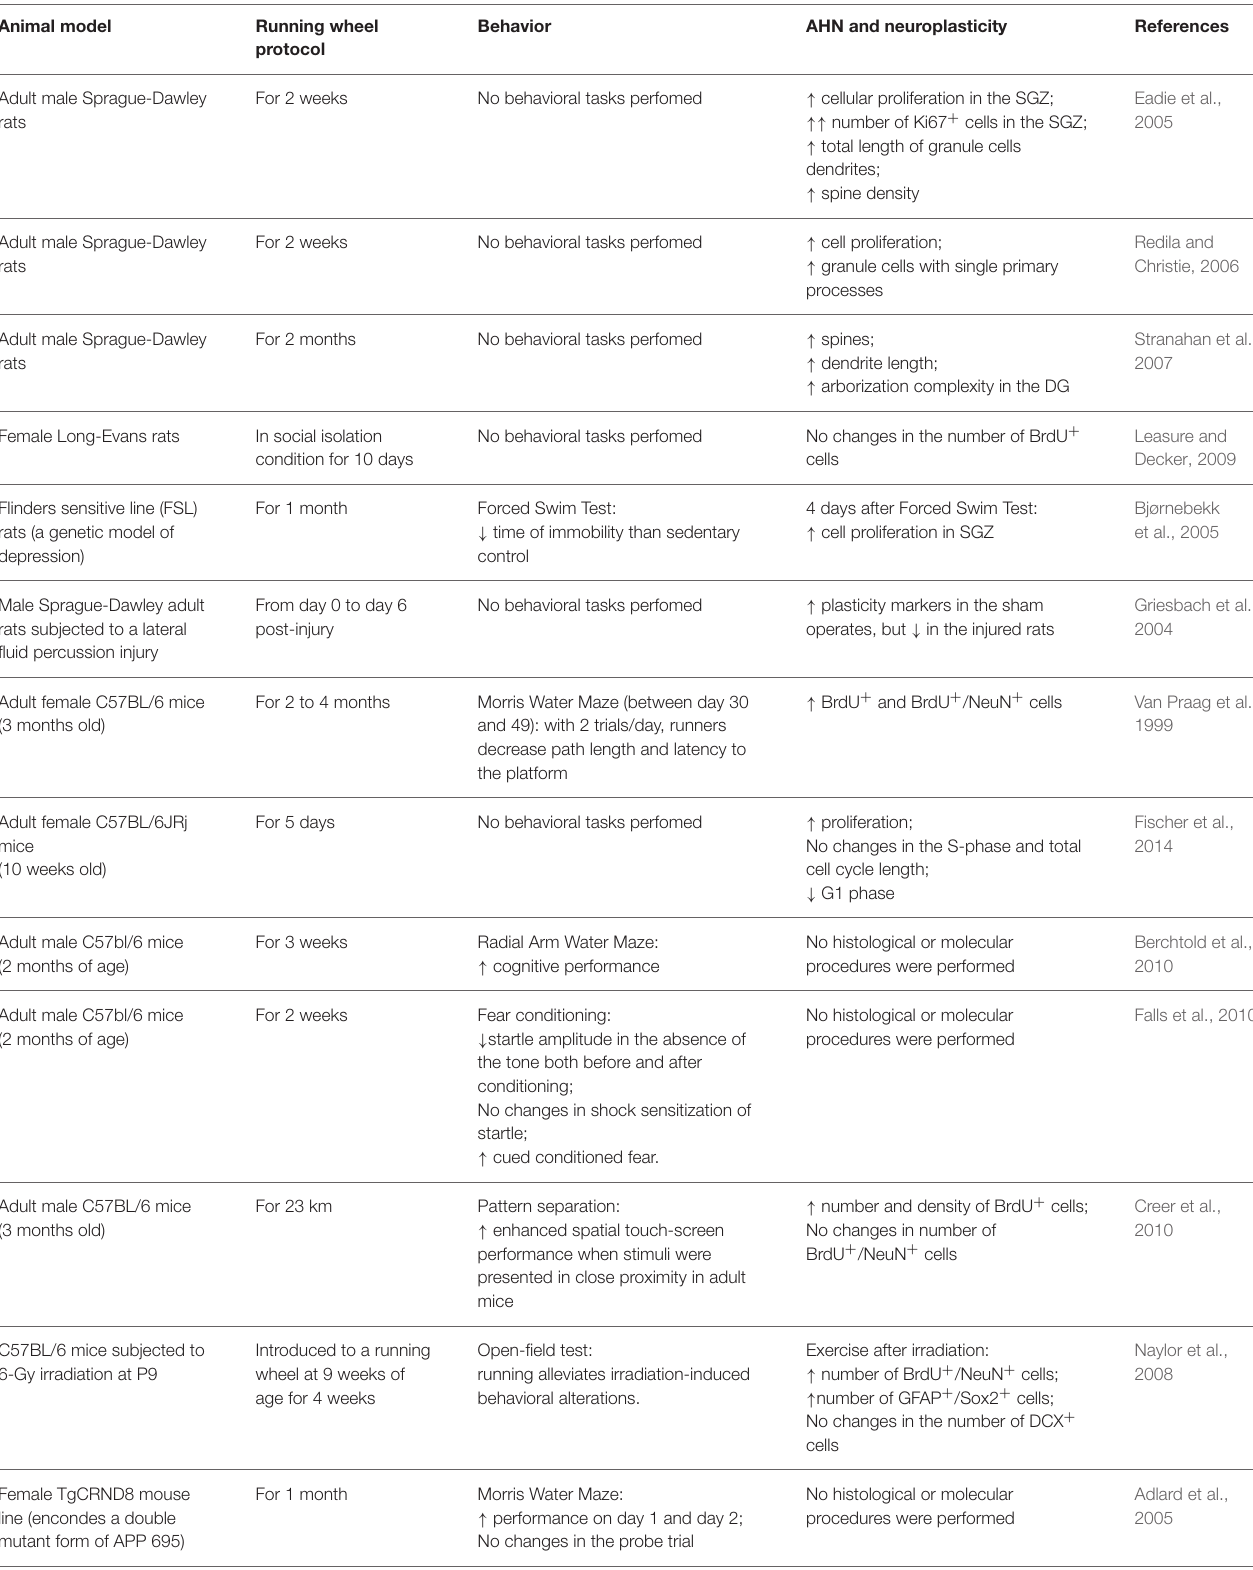
TABLE 2 | Examples of voluntary exercise protocols (running